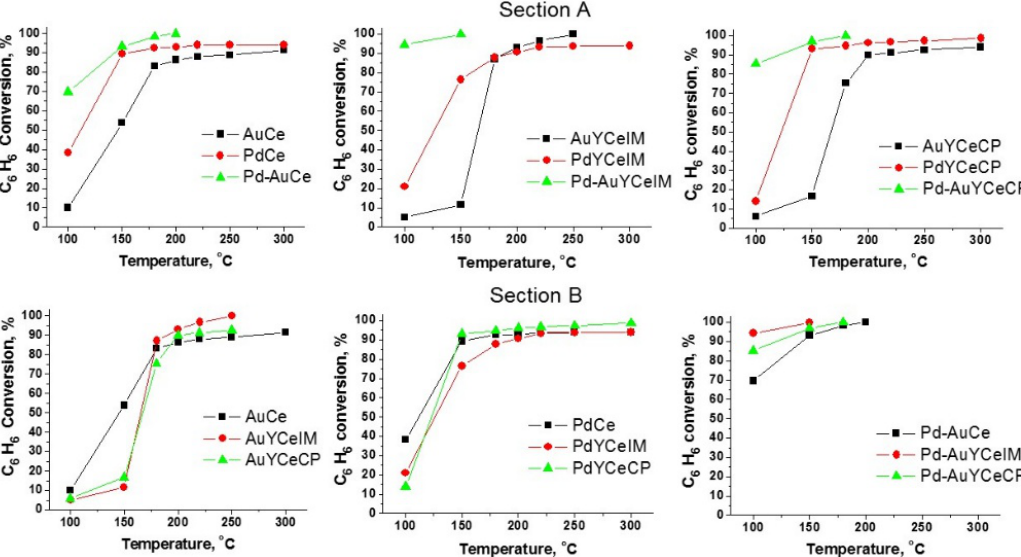
Figure 1. Benzene conversion as function of temperature ( A ) for the different catalyst formulations over the same supports; ( B ) for the same formulation over the three different supports.